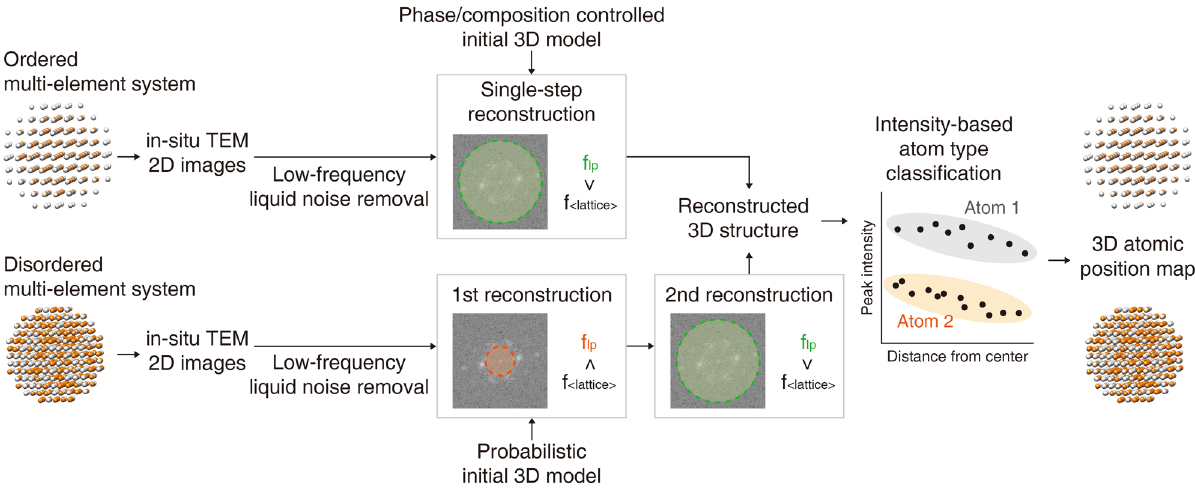
Figure 1. Overview of 3D reconstruction of multi-element nanoparticles. Ordered and disordered multi- element nanoparticles follow different pathways to obtain the atomic-resolution 3D structure. Low-frequency liquid noise is removed from the in-situ 2D TEM images first. Ordered multi-element systems are reconstructed through single-step reconstruction. The initial 3D model for ordered multi-element systems is phase and composition-controlled and the low-pass filter cutoff frequency includes the majority of the power spectrum peaks. Disordered multi-element systems are reconstructed through two-step reconstruction. The initial 3D model for disordered multi-element systems is obtained through probabilistic ab initio 3D reconstruction, with a low-pass limit cut-off frequency that vary depending on the stage of reconstruction (1st step: excluding lattice, 2nd step: including lattice). After the reconstruction, atom types are classified through analyzing the density variations in the reconstructed 3D